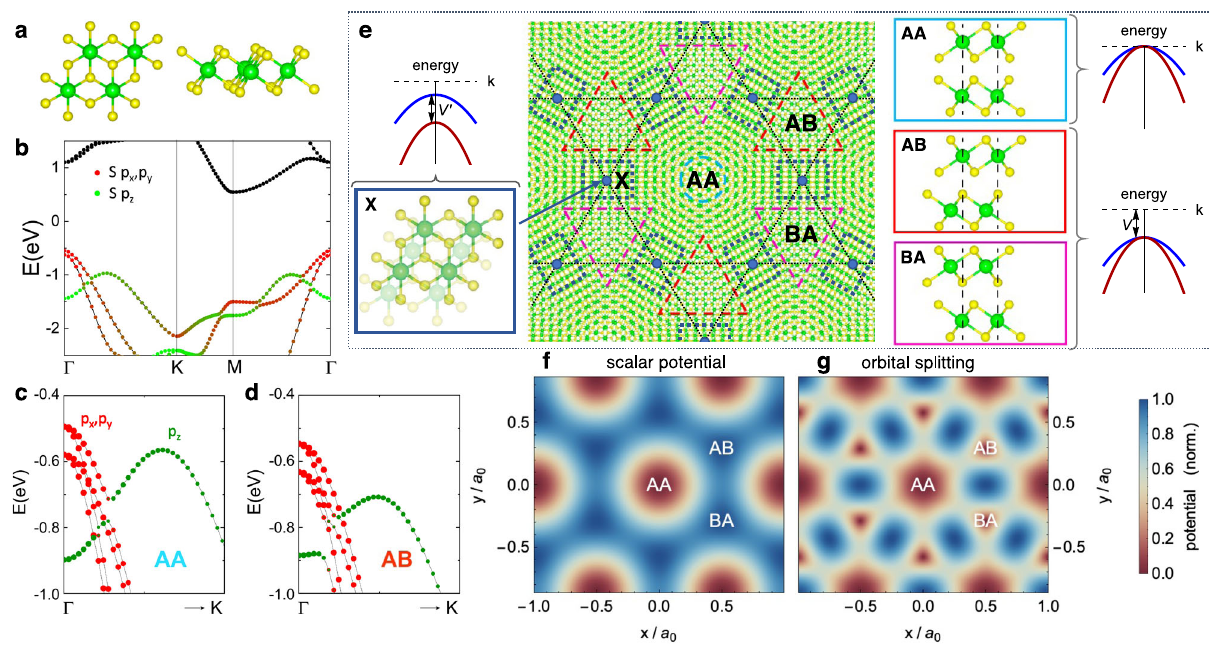
Fig. 1 Moiré patterns of twisted ZrS 2 bilayers. a Top and side view of the 1T structure of ZrS 2 . b The band structure of ZrS 2 monolayer hosts a valence band maximum at Γ composed of the p x , p y chalcogen orbital J = ± 3/2 states, with a spin-orbit splitting of ~ 100 meV. c , d In aligned bilayers with AA or AB stacking, the valence band maximum at Γ (composed of of antibonding states of p x , p y symmetry) is energetically separated by ~ 50meV from bonding p p p p p x , y states and z orbitals. Hence, antibonding x , y states compose the top-most moiré valence bands at small twist angles. e In small-angle twisted heterostructures of ZrS 2 , the interlayer alignment interpolates from AA to AB/BA stacking as a function of position in the moiré unit cell. The p x , p y antibonding states remain degenerate for both AA and AB/BA stacking in the absence of spin-orbit coupling. Their overall energetic shift is encoded in f as an effective scalar moiré superlattice potential, with minima that form a moiré honeycomb lattice. g Crucially, the loss of rotational symmetry away from local AA, AB stacking further splits the p x , p y states. This orbital splitting contribution to the moiré potential is maximal in three “ domain wall ” regions “ X ” in the moiré unit cell [(e)]; upon exceeding the scalar potential, electrons in the top-most moiré valence band form an emergent moiré Kagome lattice [dashed lines in e ; guide to the